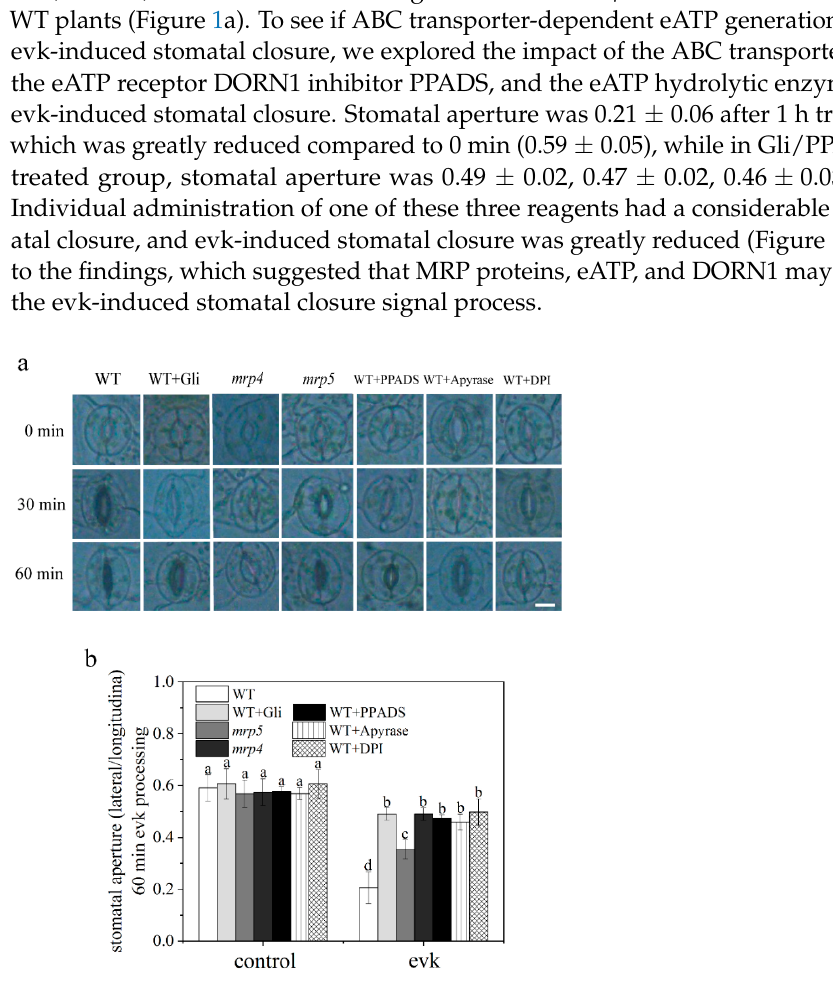
Figure 1. Time–response curves of evk induced stomatal closing in Arabidopsis. ( a ) Representative stomatal aperture of guard cells at 0 min, 30 min, and 60 min. Scale bar = 10 µ m. Gli (the inhibiter of ABC transporter), PPADS (the inhibiter of eATP receptor DORN1), DPI (the inhibiter of NADPHase), and the Apyrase (eATP degradation) partially impaired the function of evk-induced stomatal closure. The point before evk treatment was treated as 0 min. ( b ) Histogram of stomatal aperture after 60 min evk treatment. The vertical scale represents the ratio of lateral length and longitudinal length. Data were obtained from at least 60 guard cells from different plants. Bars represent the standard error of the